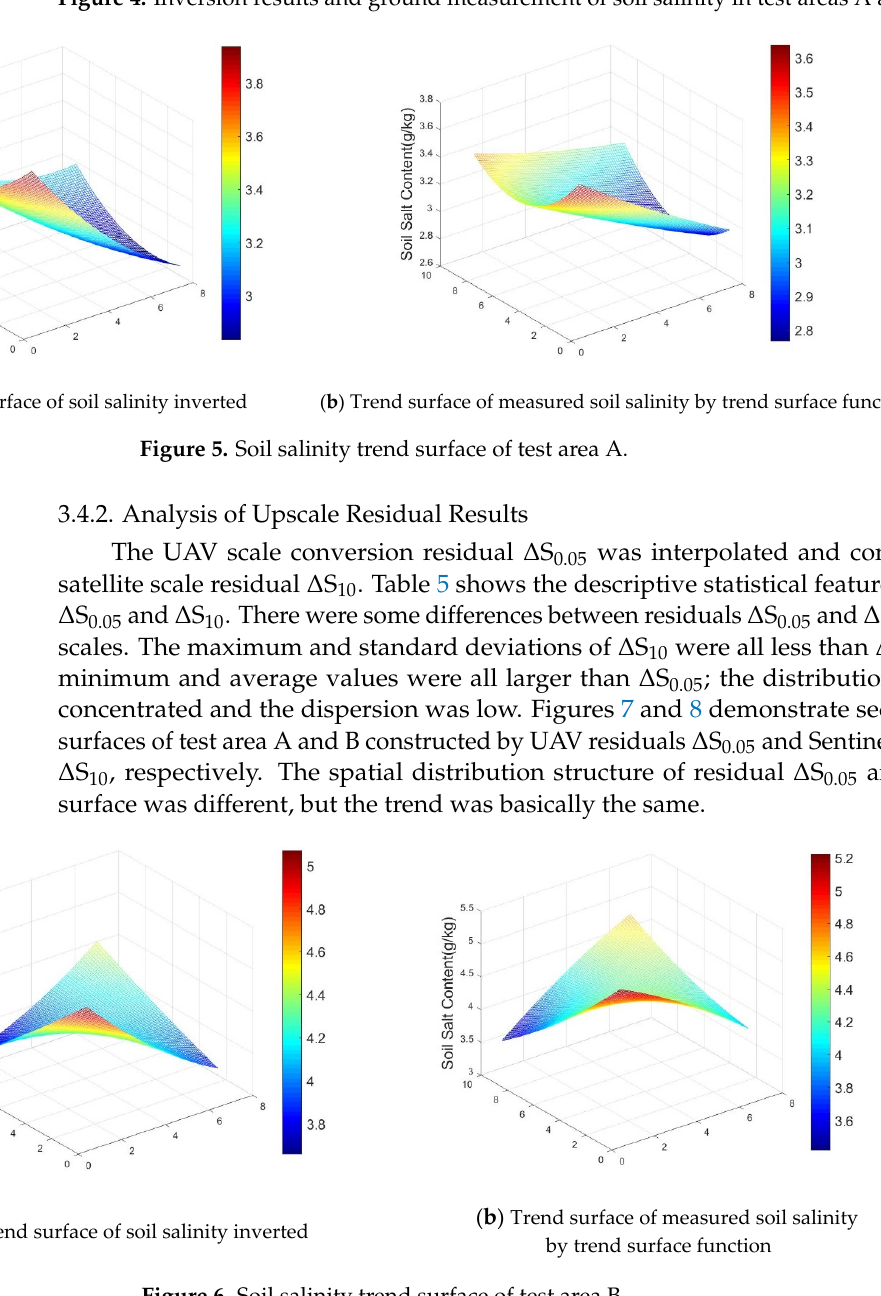
Figure 6. Soil salinity trend surface of test area B.